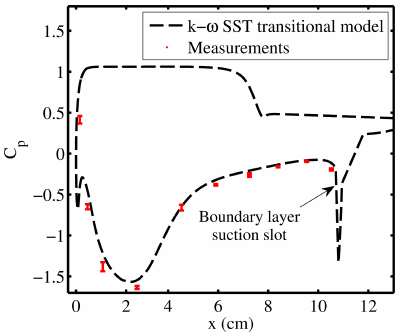
Figure 10. Pressure distribution around the blunt body housing of BASE-II. Data from ICE–Trf04 (11 July 2011, 16:15–16:20UTC); Simulation boundary conditions: P = 400mbar, Ma 0.47.